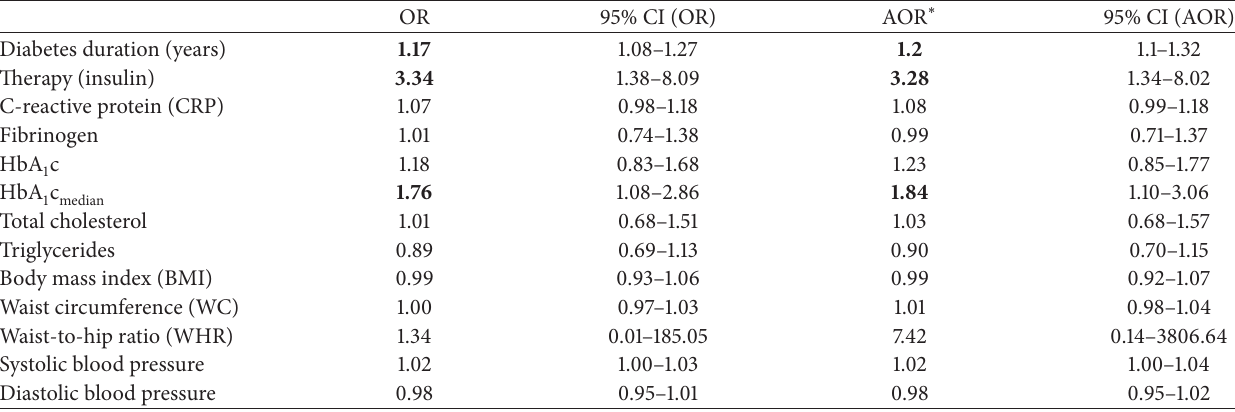
Table 4: Odds ratios (95% CIs) for diabetic retinopathy associated with basic characteristics, inflammatory and haemostatic markers, other markers of endothelial dysfunction, and anthropometric and clinical parameters in type 2 diabetic patients ( 𝑛 = 107